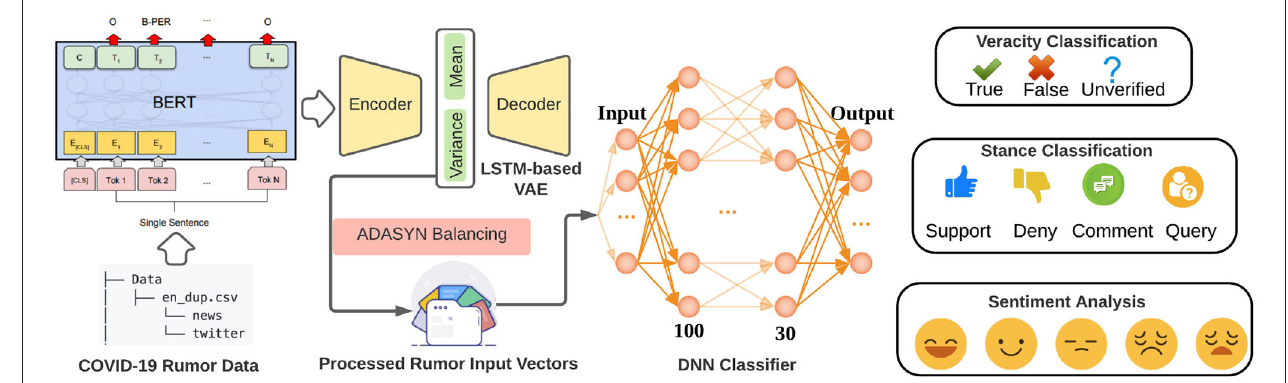
FIGURE 9 | Our rumor deep learning-based classification system. Textural sentences in our dataset are first converted to vectors using Bidirectional Encoder Representations from Transformers (BERT), and then sent through an LSTM-based Variational AutoEncoder (VAE) to extract features. After the ADASYN balancing,